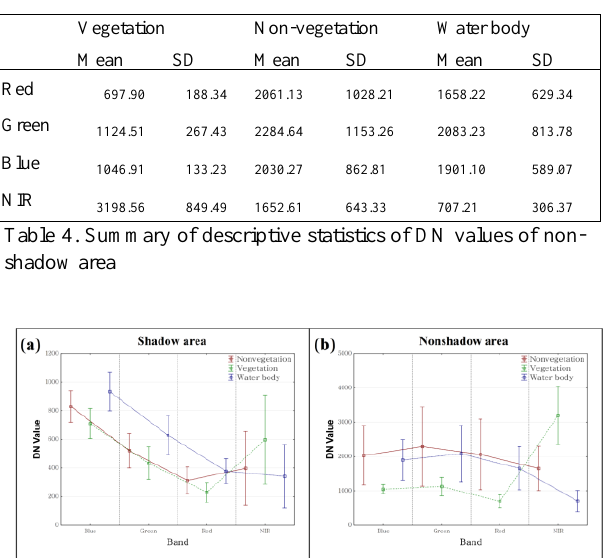
Figure 2. The multispectral image for training spectra (digital number value) in (a) shadow areas and (b) non- shadow areas. Note: Center squares indicate mean, and the whisker one standard